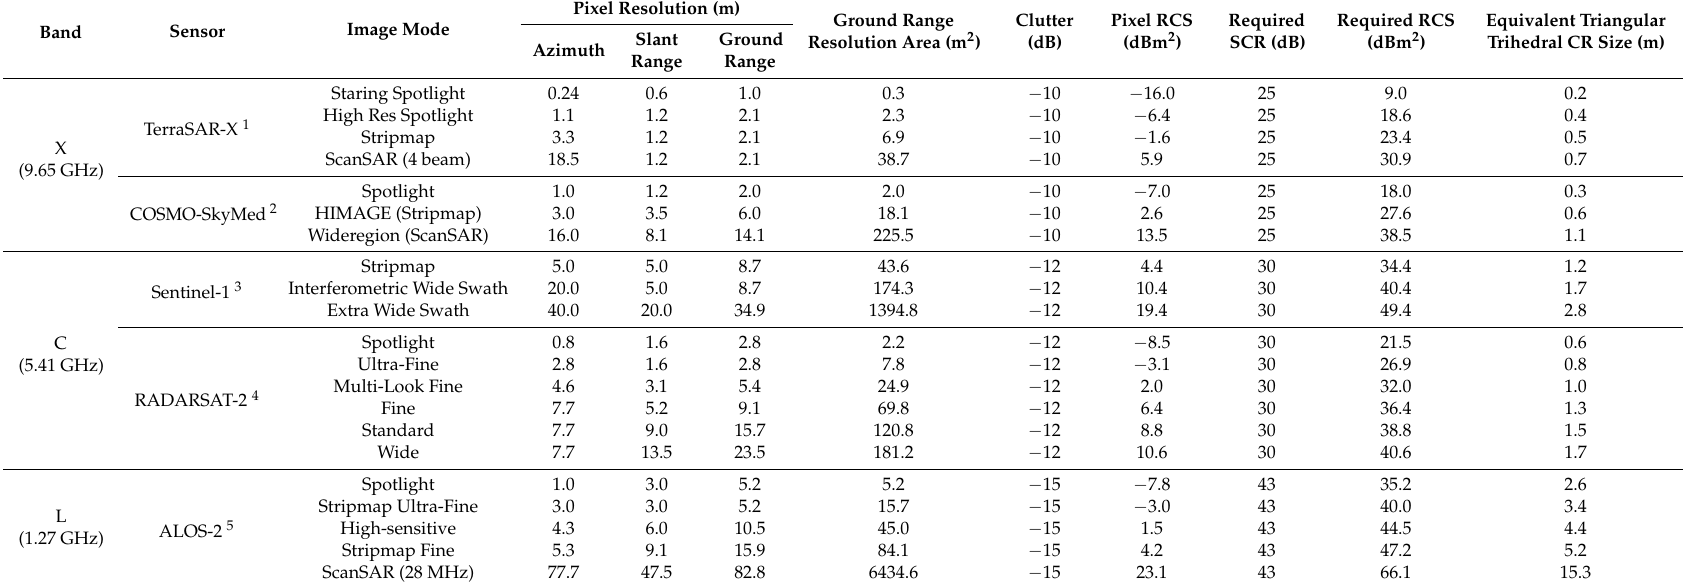
Table 1. Estimates of target RCS and the equivalent triangular trihedral CR required to achieve a LOS displacement error of 0.1 mm for different SAR sensors and imaging modes. Ground range resolution areas are calculated for a 35 ◦ local incidence angle using pixel resolution information available from the online sources (retrieved 3 April 2017) listed below the table. Pixel resolutions are for single polarisation SLC products. All calculated values are rounded to one decimal place for